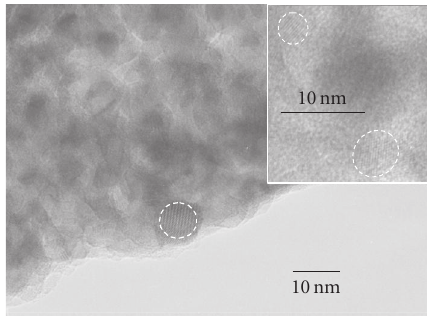
Figure 3: High-resolution TEM image of the TiO 2 nanoparticles immobilized into the nanoporous silica substrate (LIMHP